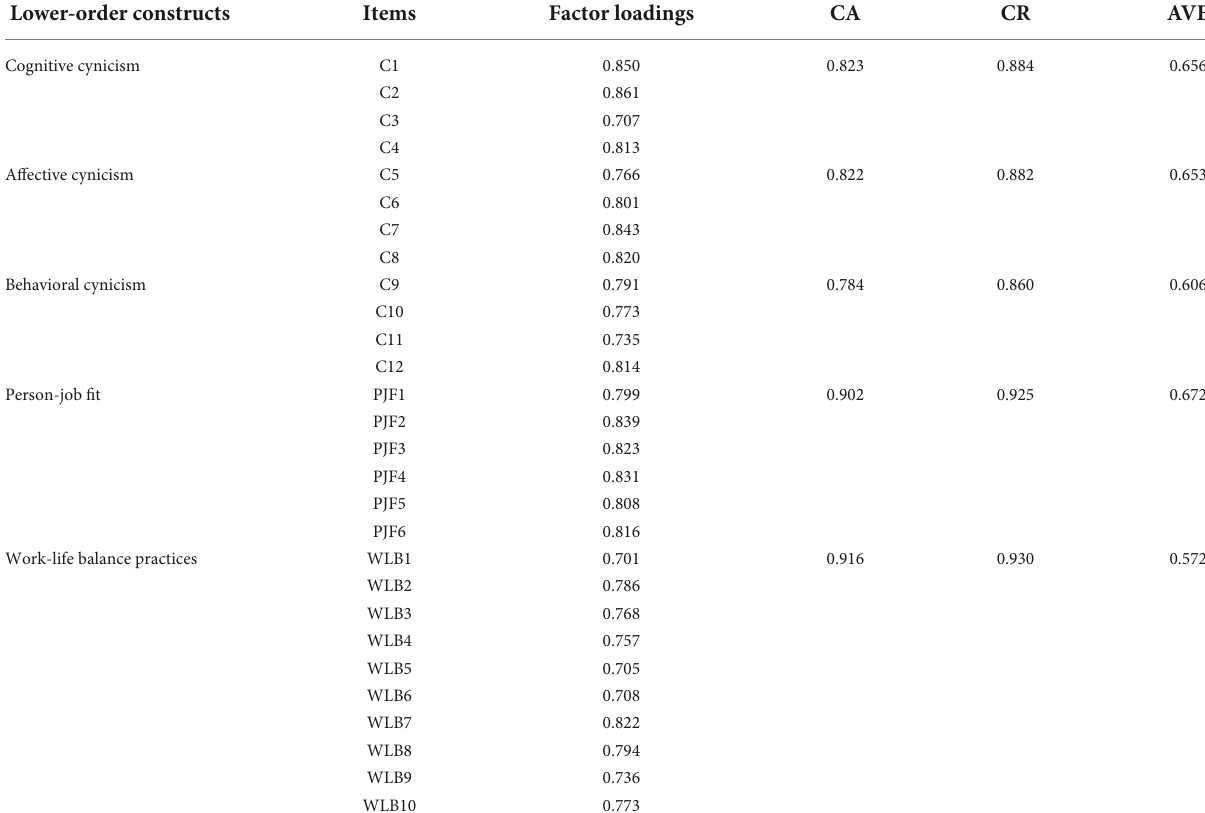
TABLE 2 Measurement properties of lower-order